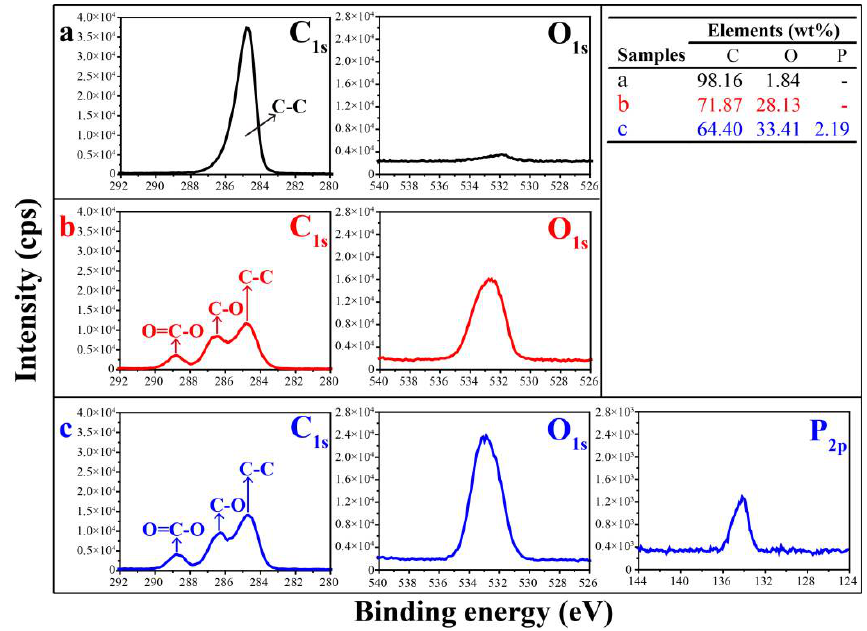
Figure 3. XPS spectra and the elements (inserted Table) of ( a ) pristine UHMWPE, ( b ) UHMWPE-g-PGMA (DG = 540%), and ( c ) UHMWPE-g-PO 4 (D PO = 1.93 mmol · g − 1 ) fibers.